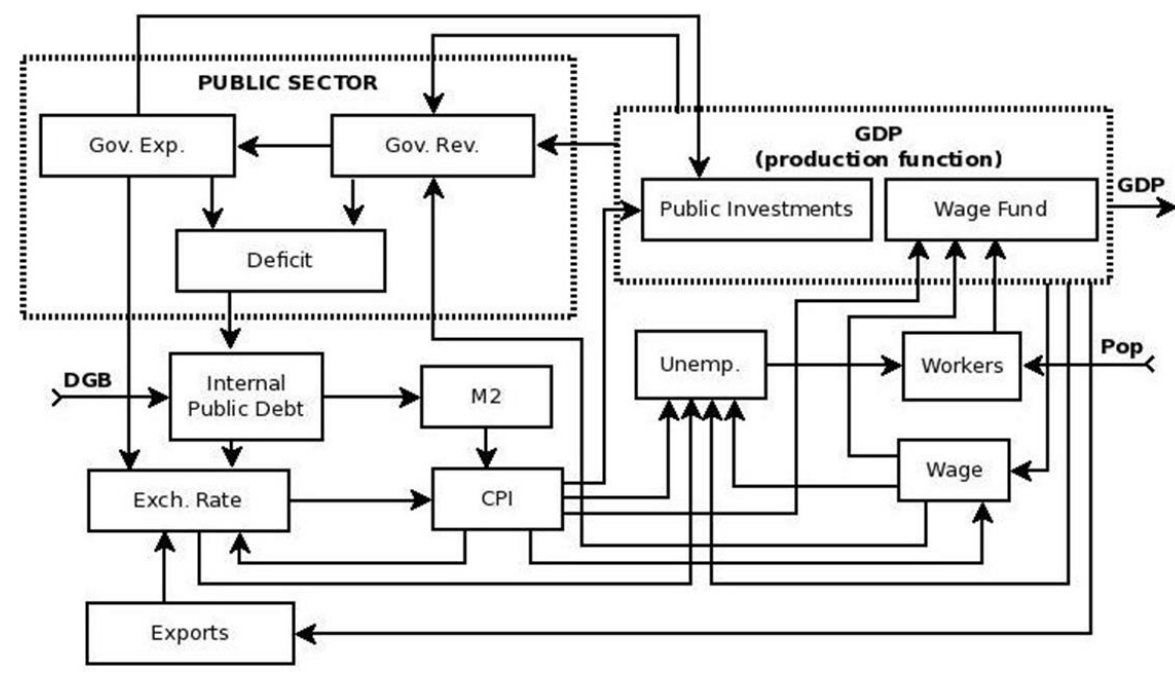
Figure 2. The block diagram of fiscal-monetary interaction